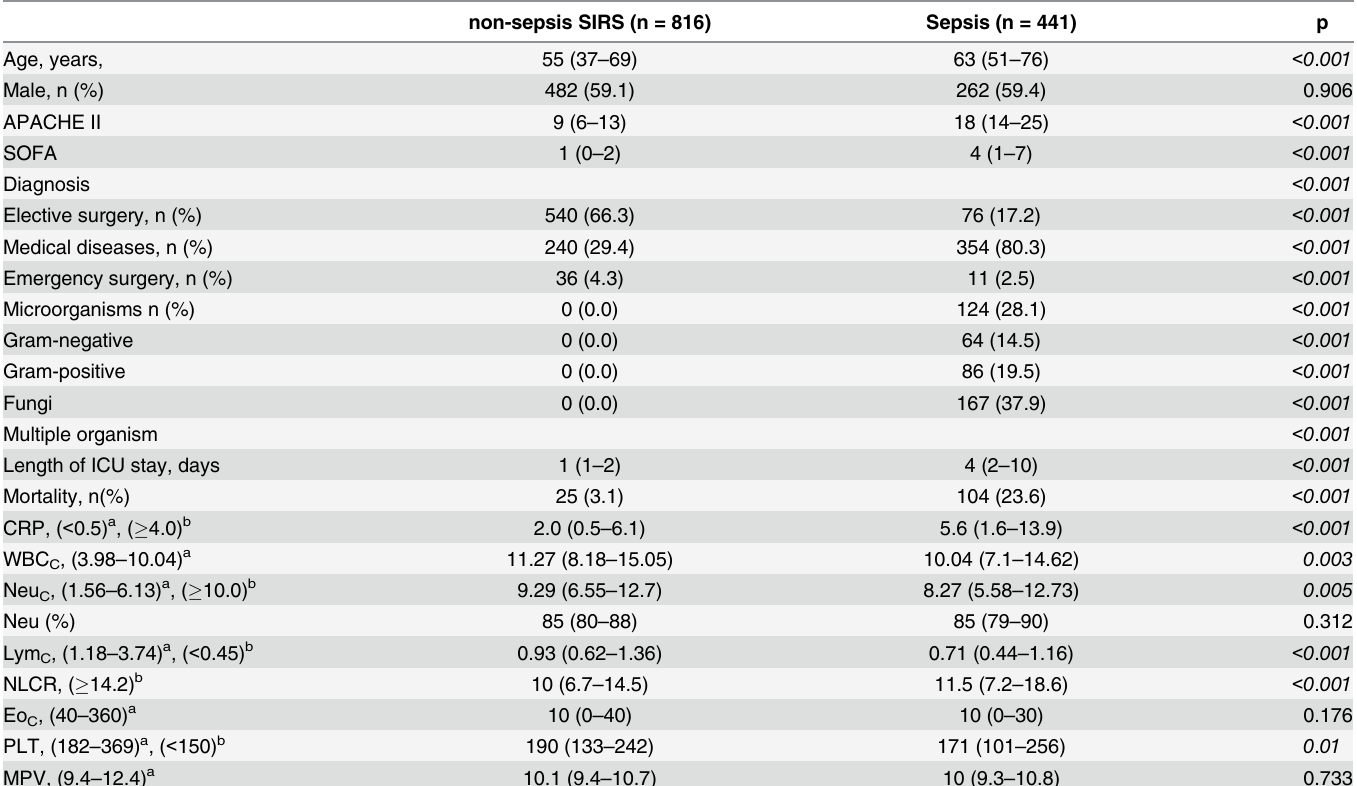
Table 1. Demografic data and clinicall outcome.